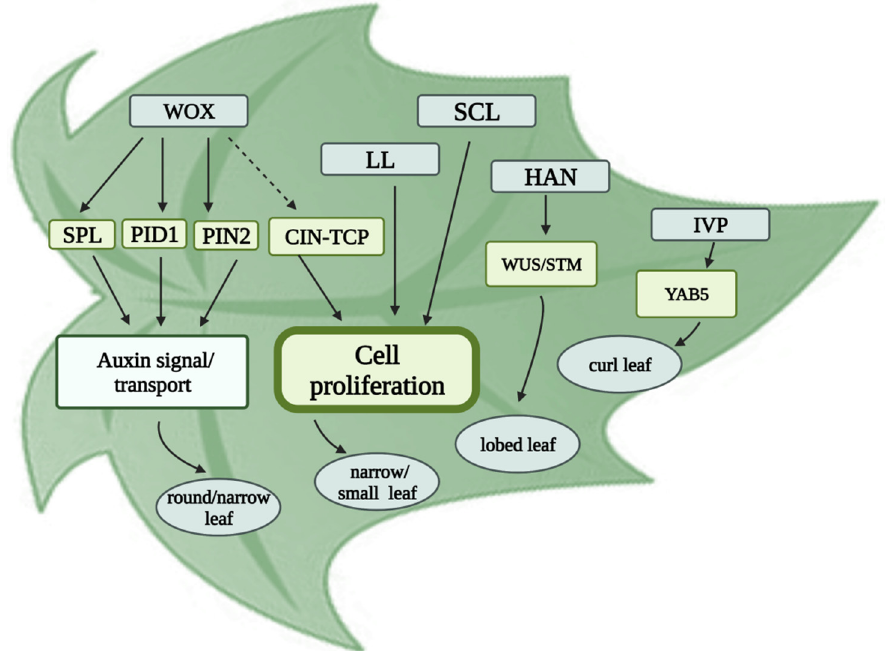
Figure 1. Genetic and molecular regulation mechanisms of cucumber leaf morphology. The grey box indicates the genes/proteins related to leaf morphology identified in cucumber. The yellow box indicates the gene or protein regulated by the target gene. The gray oval box indicates the corresponding leaf phenotype. The arrows indicate the regulatory relationship between the two genes. Abbreviations in figure, WOX: Wuschel-related homeobox; LL: little leaf; SCL: small and cordate leaf; HAN: Hanaba Taranu; IVP: irregular vasculature patterning; SPL: SPOROCYTELESS; PID1: PINOID 1; PIN2: PIN-FROMED 2; STM: Shoot Meristemless).